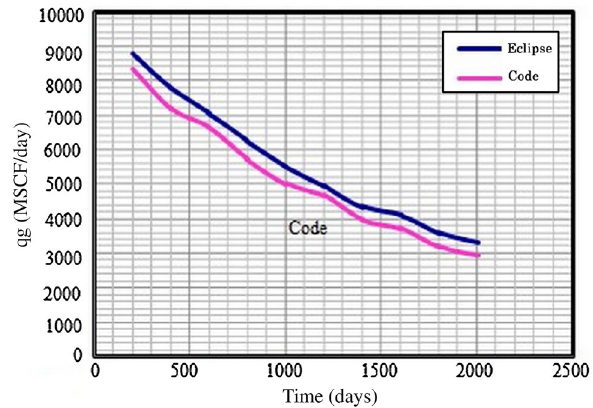
Fig. 7 Water flow rate versus time for well No. 1 of case #1